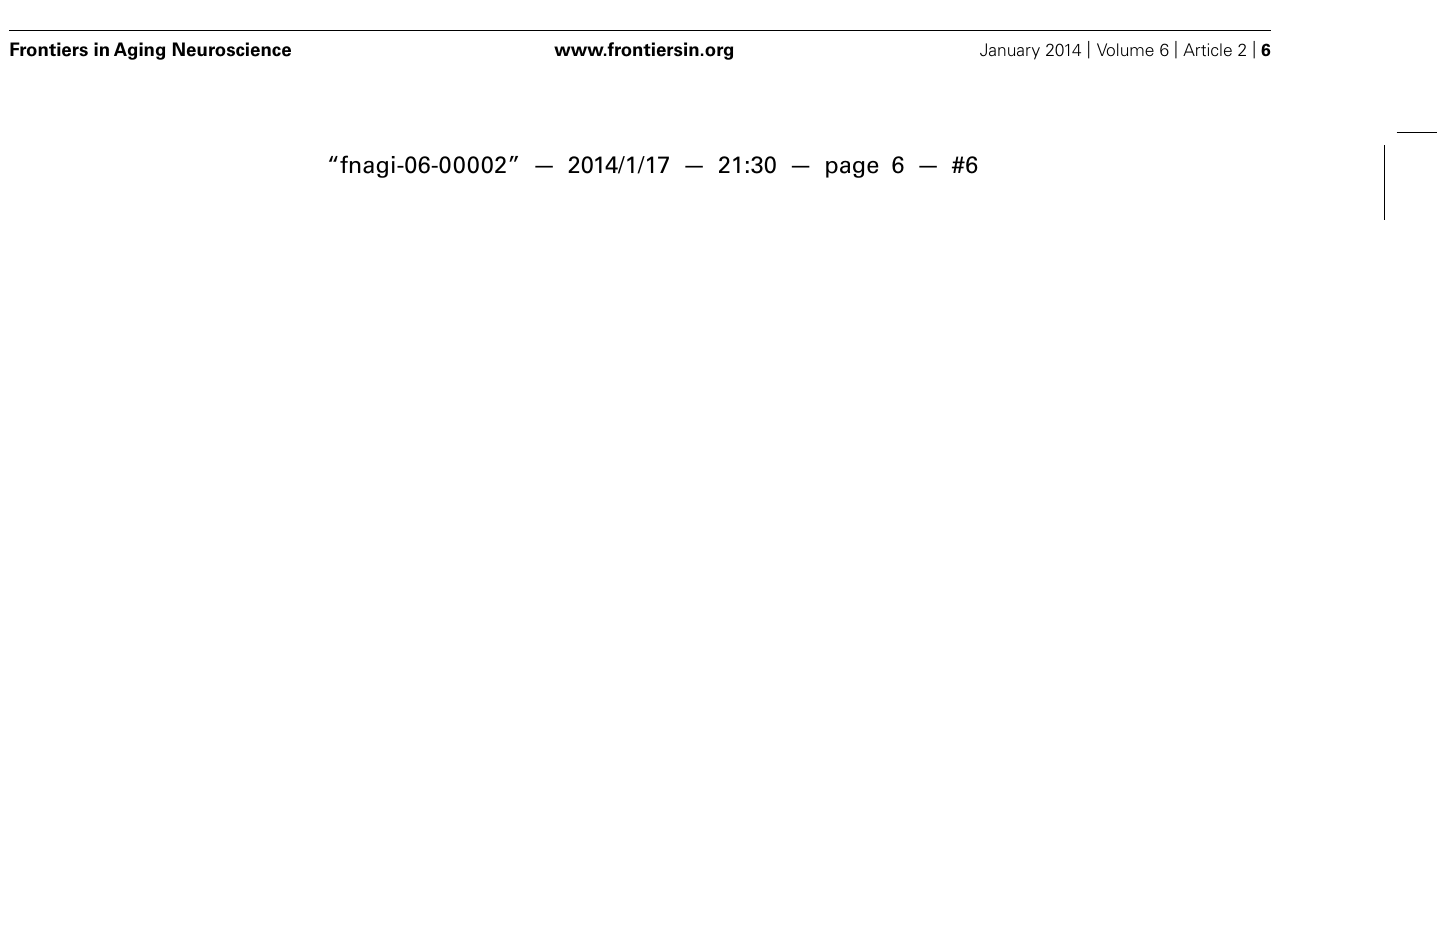
FIGURE 5 | Carryover effects due the initial spatial training. The figure illustrates the mean distance + SEM to escape during the first training block for the initial and second spatial training sessions.The distance decreased across sessions, regardless of age indicating a carryover effect for some aspects of the task. An effect of the platform location was observed for the second session of training due to young and middle-age rats exhibiting